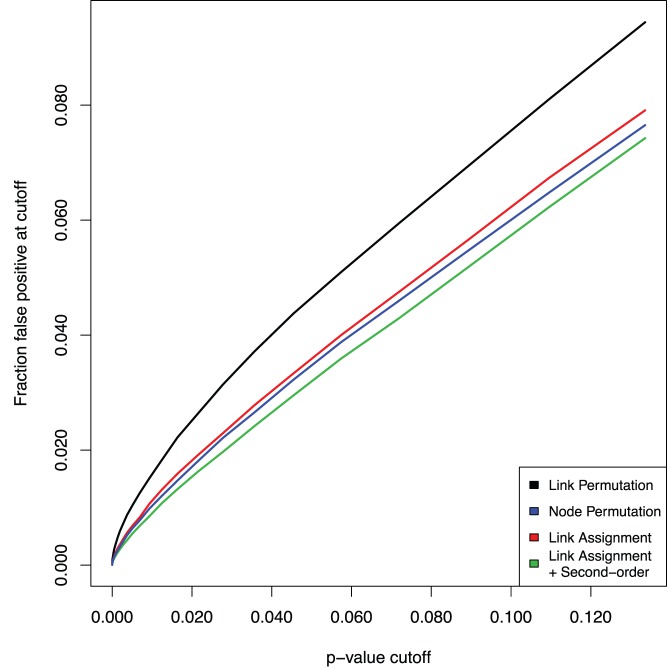
Comparison of the false positive rate for the four different methods.A result was considered false positive if it passed the normality criterion (reduced chi-squared < = 1) and had a p-value below a certain cutoff. Shown is the false positive rate as a function of the p-value. The test was performed using randomized KEGG pathways mapped to the FunCoup network.